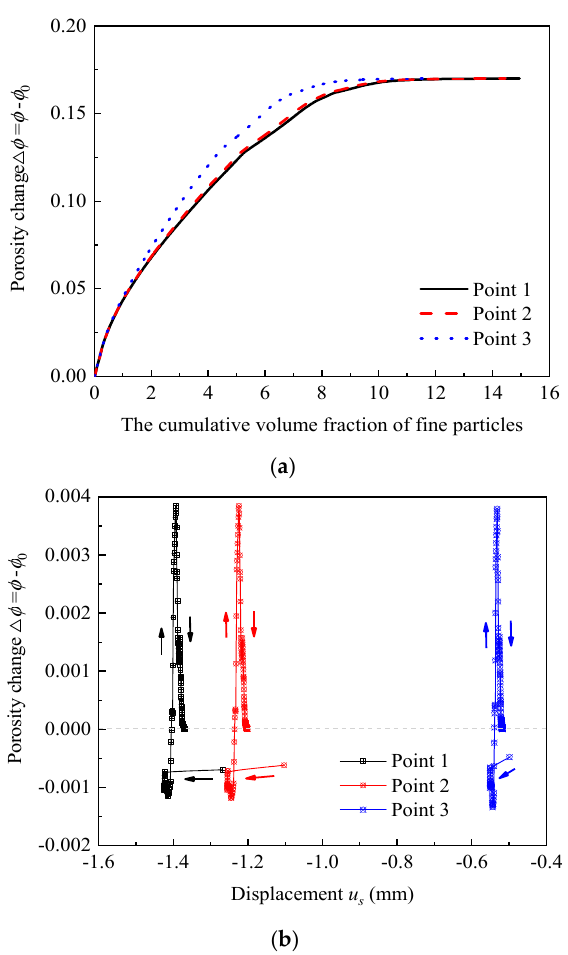
Figure 22. ( a ) The relation curves of porosity change and cumulative volume fraction of fine particles; ( b ) the relation curves of porosity change and vertical displacement.